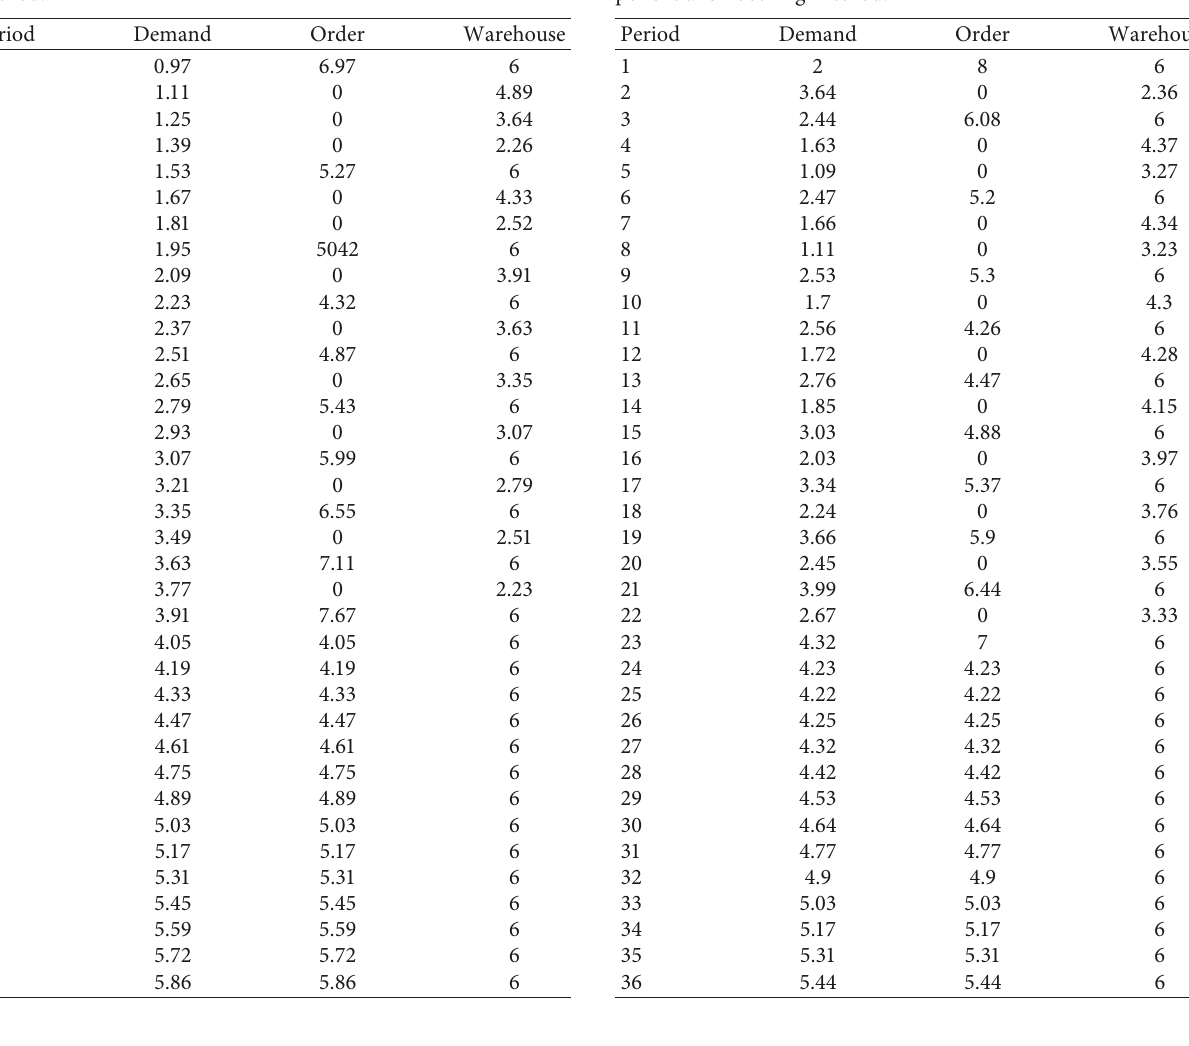
Table 4: Demand forecasting and retail order by the regression method.